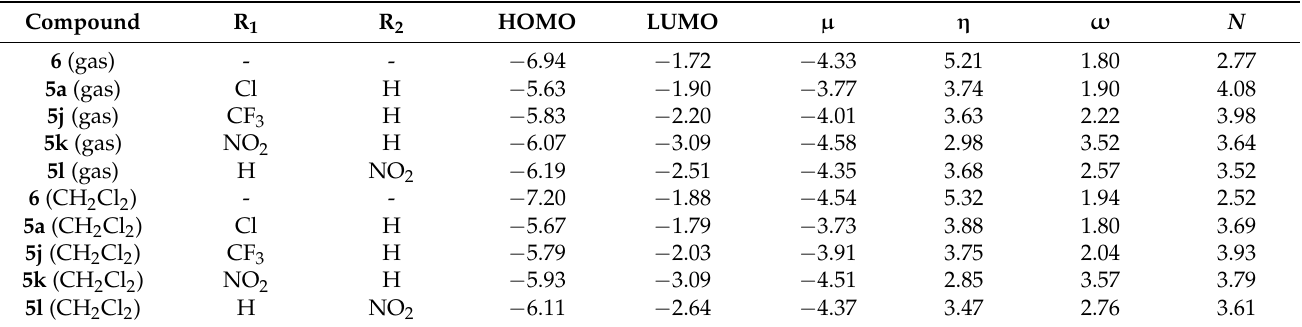
Table 3. The PBE0/def2-svpd calculated FMO energies: electronic chemical potential ( µ ), chemi- cal hardness ( η ), electrophilicity ( ω ), and nucleophilicity (N), in eV, for nitrile imines 5a, j-l ,